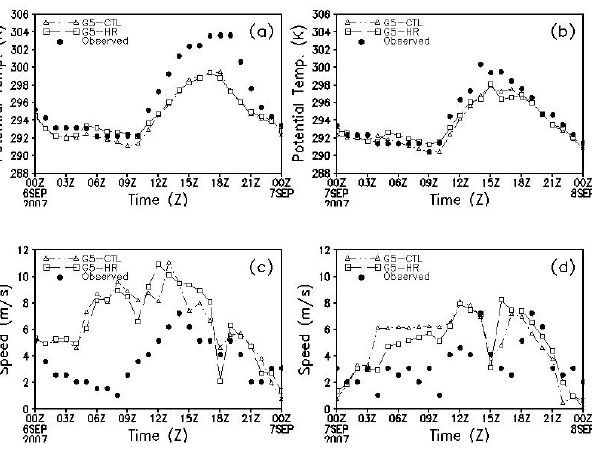
Figure 7. Time cross-section data of (a, b) θ (K), and (c, d) wind speed (ms − 1 ) observed (closed circle) and simulated by G5 of the CTL (open triangle) and HR (open square) runs from 00:00UTC 6 September to 00:00UTC 8 September 2007 at Marambaia surface weather-observation station.